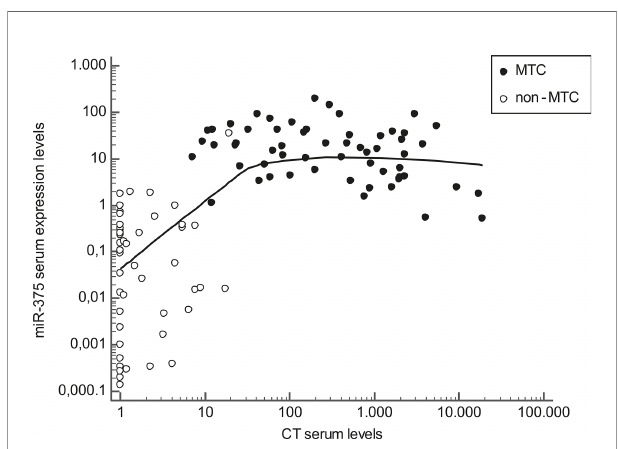
FIGURE 2 | Scatter diagram representing the correlation between calcitonin (CT) serum levels (horizontal axis) and miR-375 serum levels (vertical axis) in MTC patients (black dots) and non-MTC patients (white dots). Values are represented on a logarithmic scale.